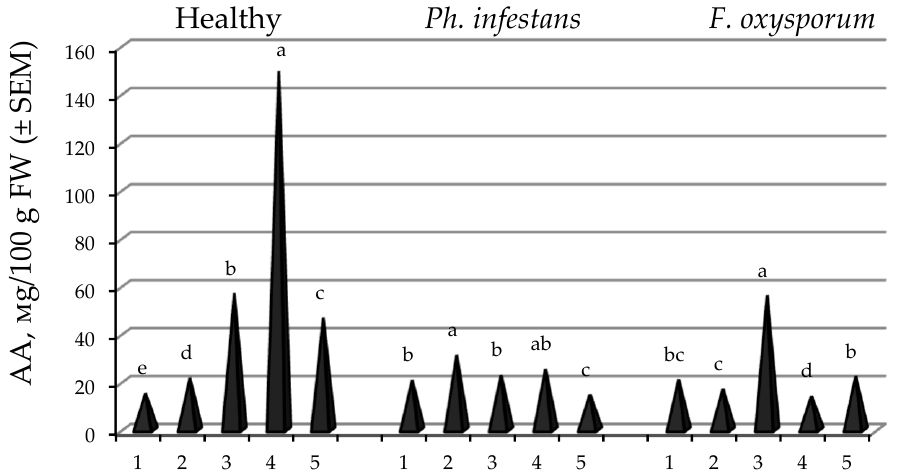
Figure 8. E ff ect of endophytic bacteria B. subtilis 10-4 and 26D both individually and in compositions with SA on AA content in healthy and infected by Ph. infestans and F. oxysporum stored potato tubers (time of storage 5 months). 1 —control (non-inoculated with B. subtilis ), 2 — B. subtilis 10-4; 3 — B. subtilis 10-4 + SA; 4 — B. subtilis 26D; 5 — B. subtilis 26D + SA. The bars are the means of three repetitions ± SEM. Different letters indicate a significant difference between the means at the probability level of p < 0.05.